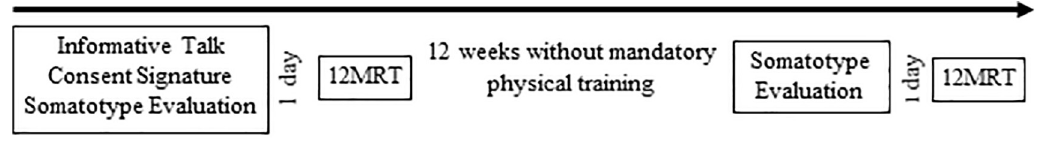
Fig 1. Research design. 12MRT: 12-minute race test.